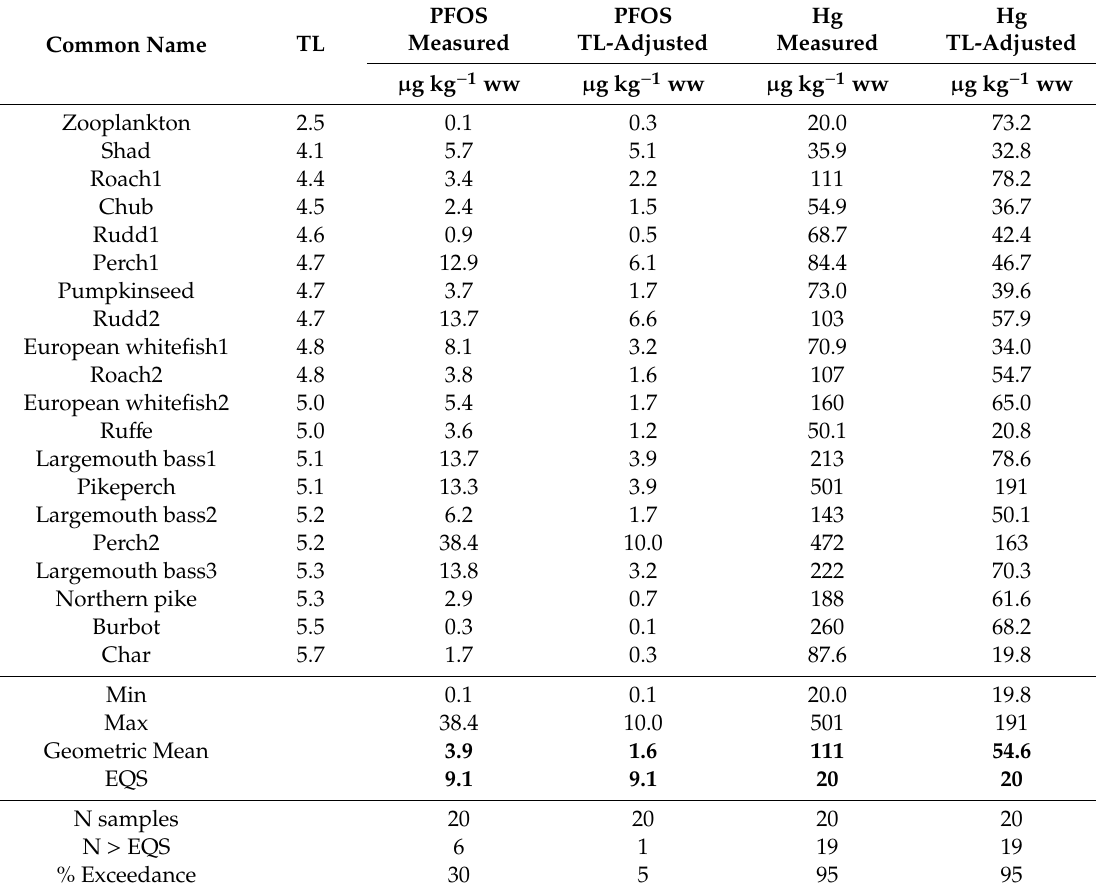
Table 4. Comparison of PFOS and Hg concentrations in fish measured and adjusted to the trophic levels (TL) by using the following TMFs: PFOS 3.0 and Hg 2.3. EQS: environmental quality